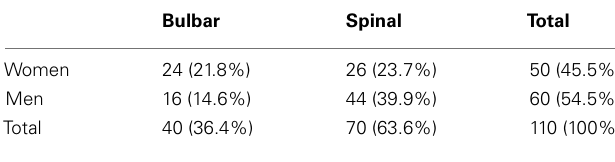
Table 1 | Sample distribution by gender and site of